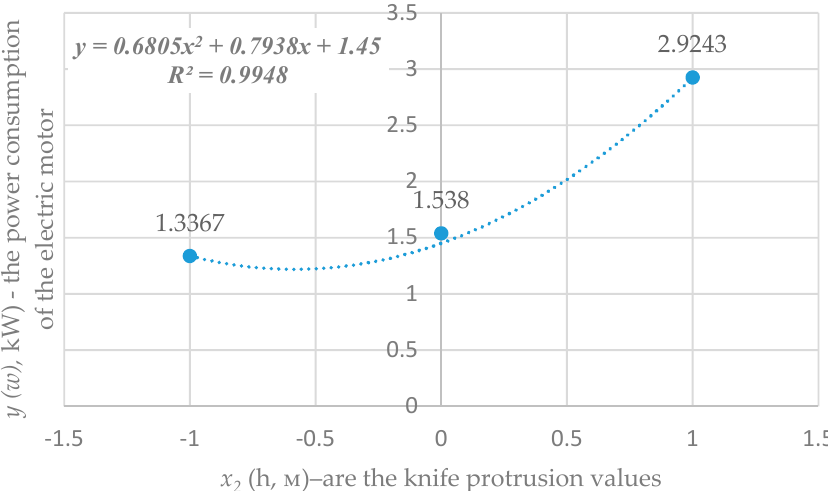
Figure 10. Graphical interpretation of the dependence of the power consumption of the branch chopper y ( w ) on the size of the knife protrusion x 2 ( h )